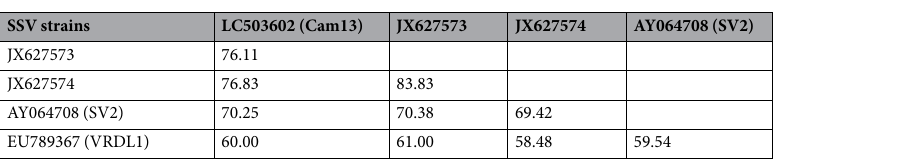
Table 2. Nucleotide sequence identities (%) among VP1 of SSV